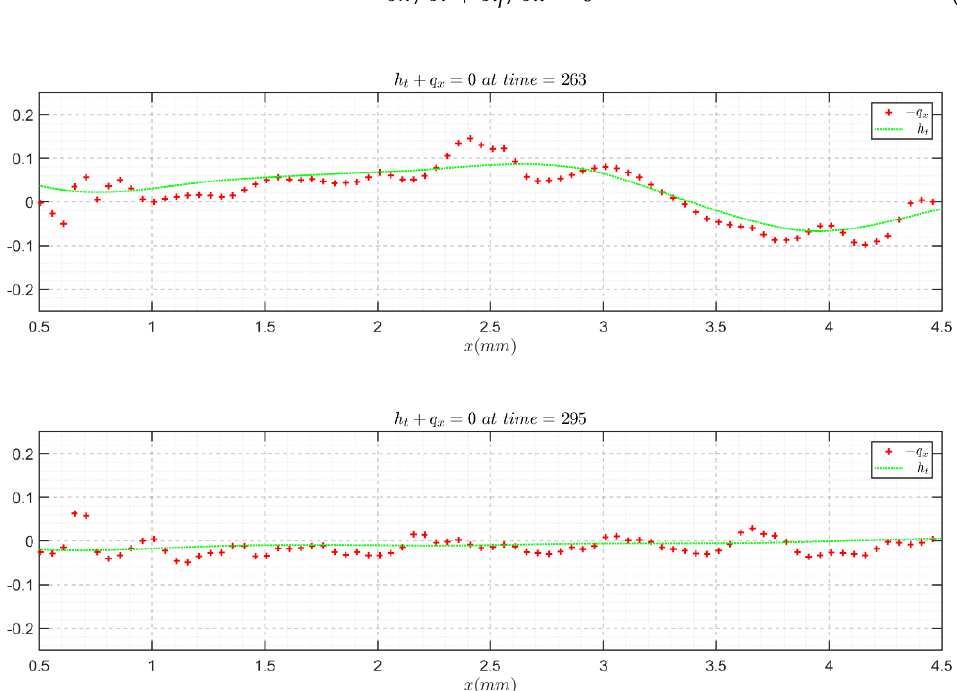
Figure 9. Continuity equation validation with the instantaneous velocity field and film topology for the Re = 41.05, f = 5 Hz water film flow case.